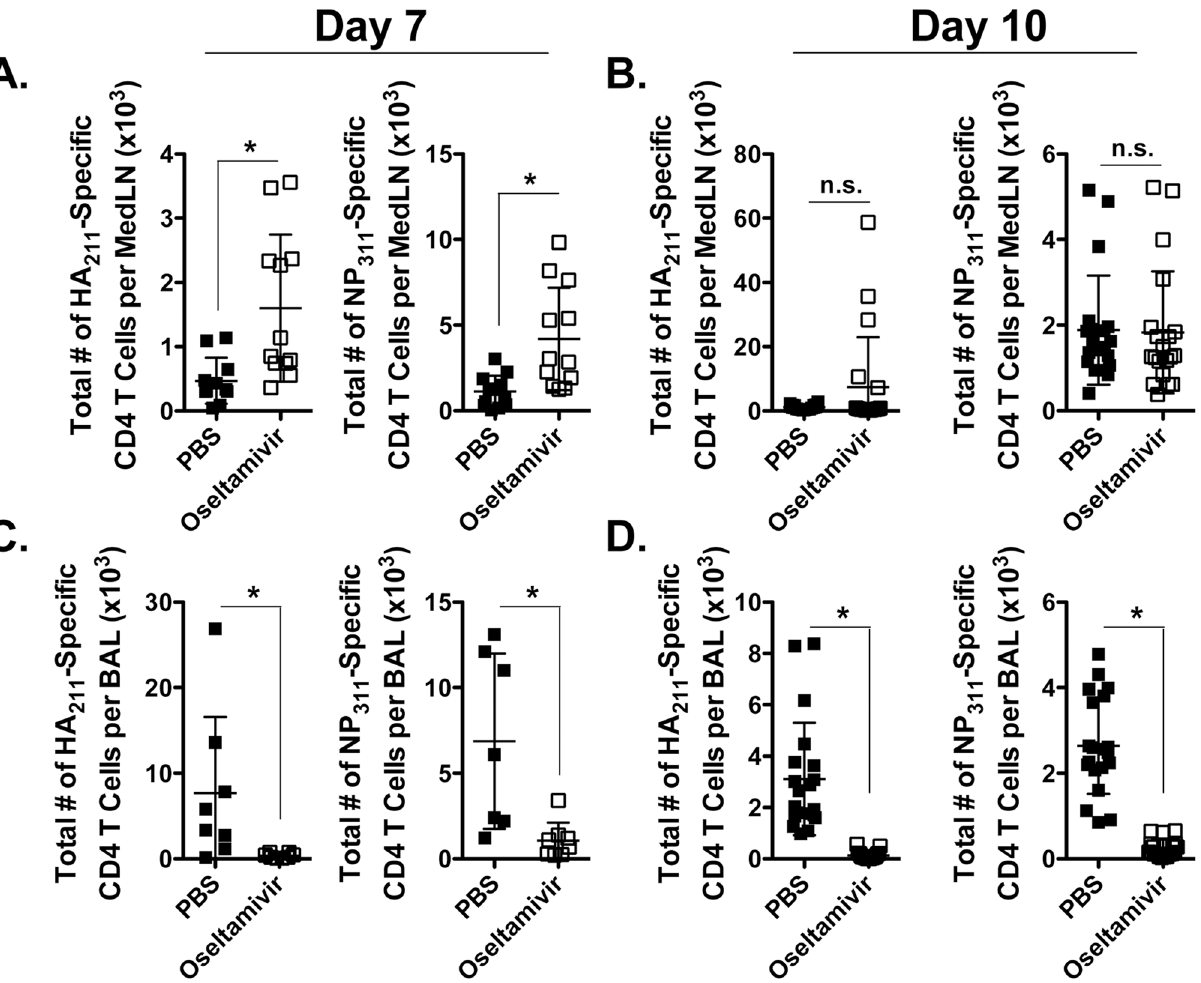
Fig 6. Influenza-specific CD4 + T cell responses in mice prophylactically treated with oseltamivir. Mice were treated with PBS or oseltamivir and infected with influenza virus X31 as in Fig 1A. At (AC) 7 and (BD) 10 days post-infection, the mediastinal LNs (MedLN) and BAL fluid were harvested and assessed for the total number of influenza IA b -HA 211 and NP 311 -specific CD4 + T cells by intracellular cytokine staining after ex vivo stimulation. These data are from 8 – 13 mice (2 individual experiments) at day 7 p.i and from 20 mice (4 individual experiments) at day 10 p.i. Error bars represent standard error of the mean. * p < 0.05. n.s., not significantly